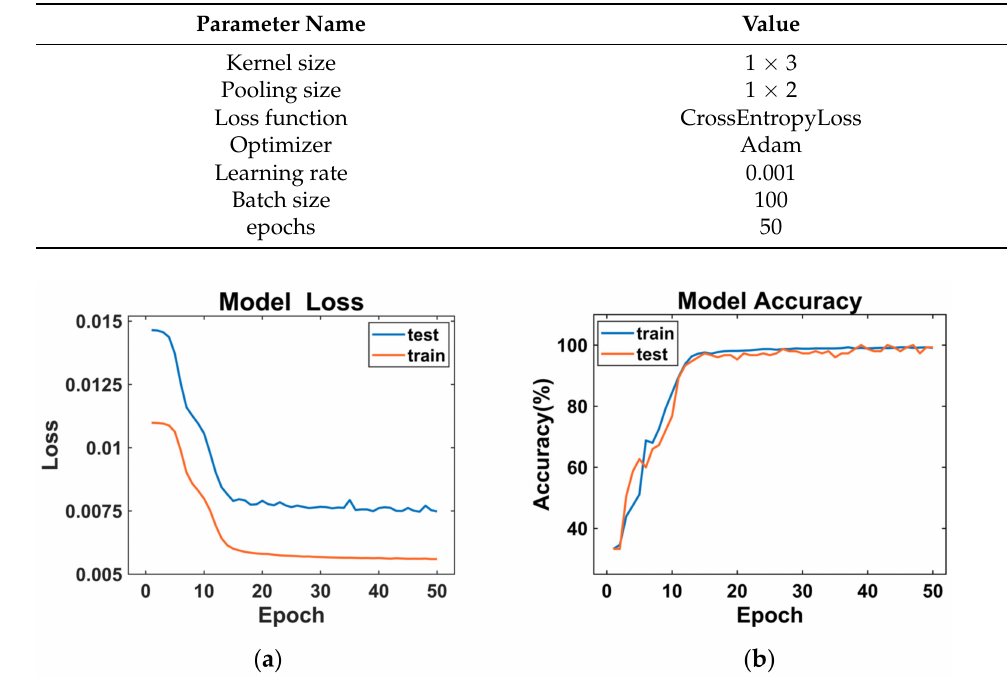
Table 3. Parameter settings of the CNN model.